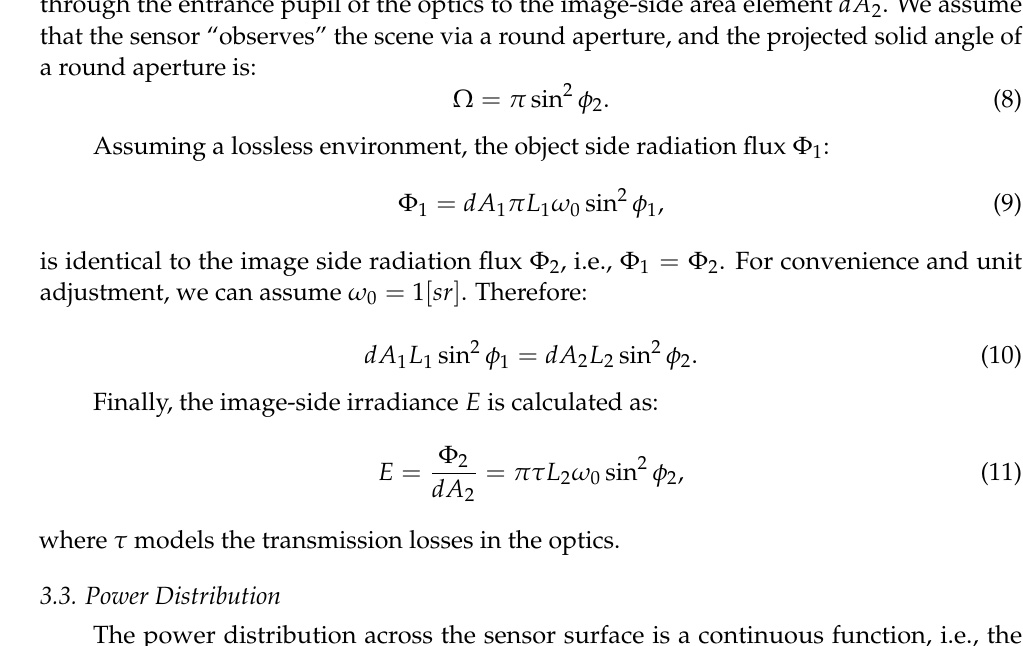
Image plane with sensor Optics